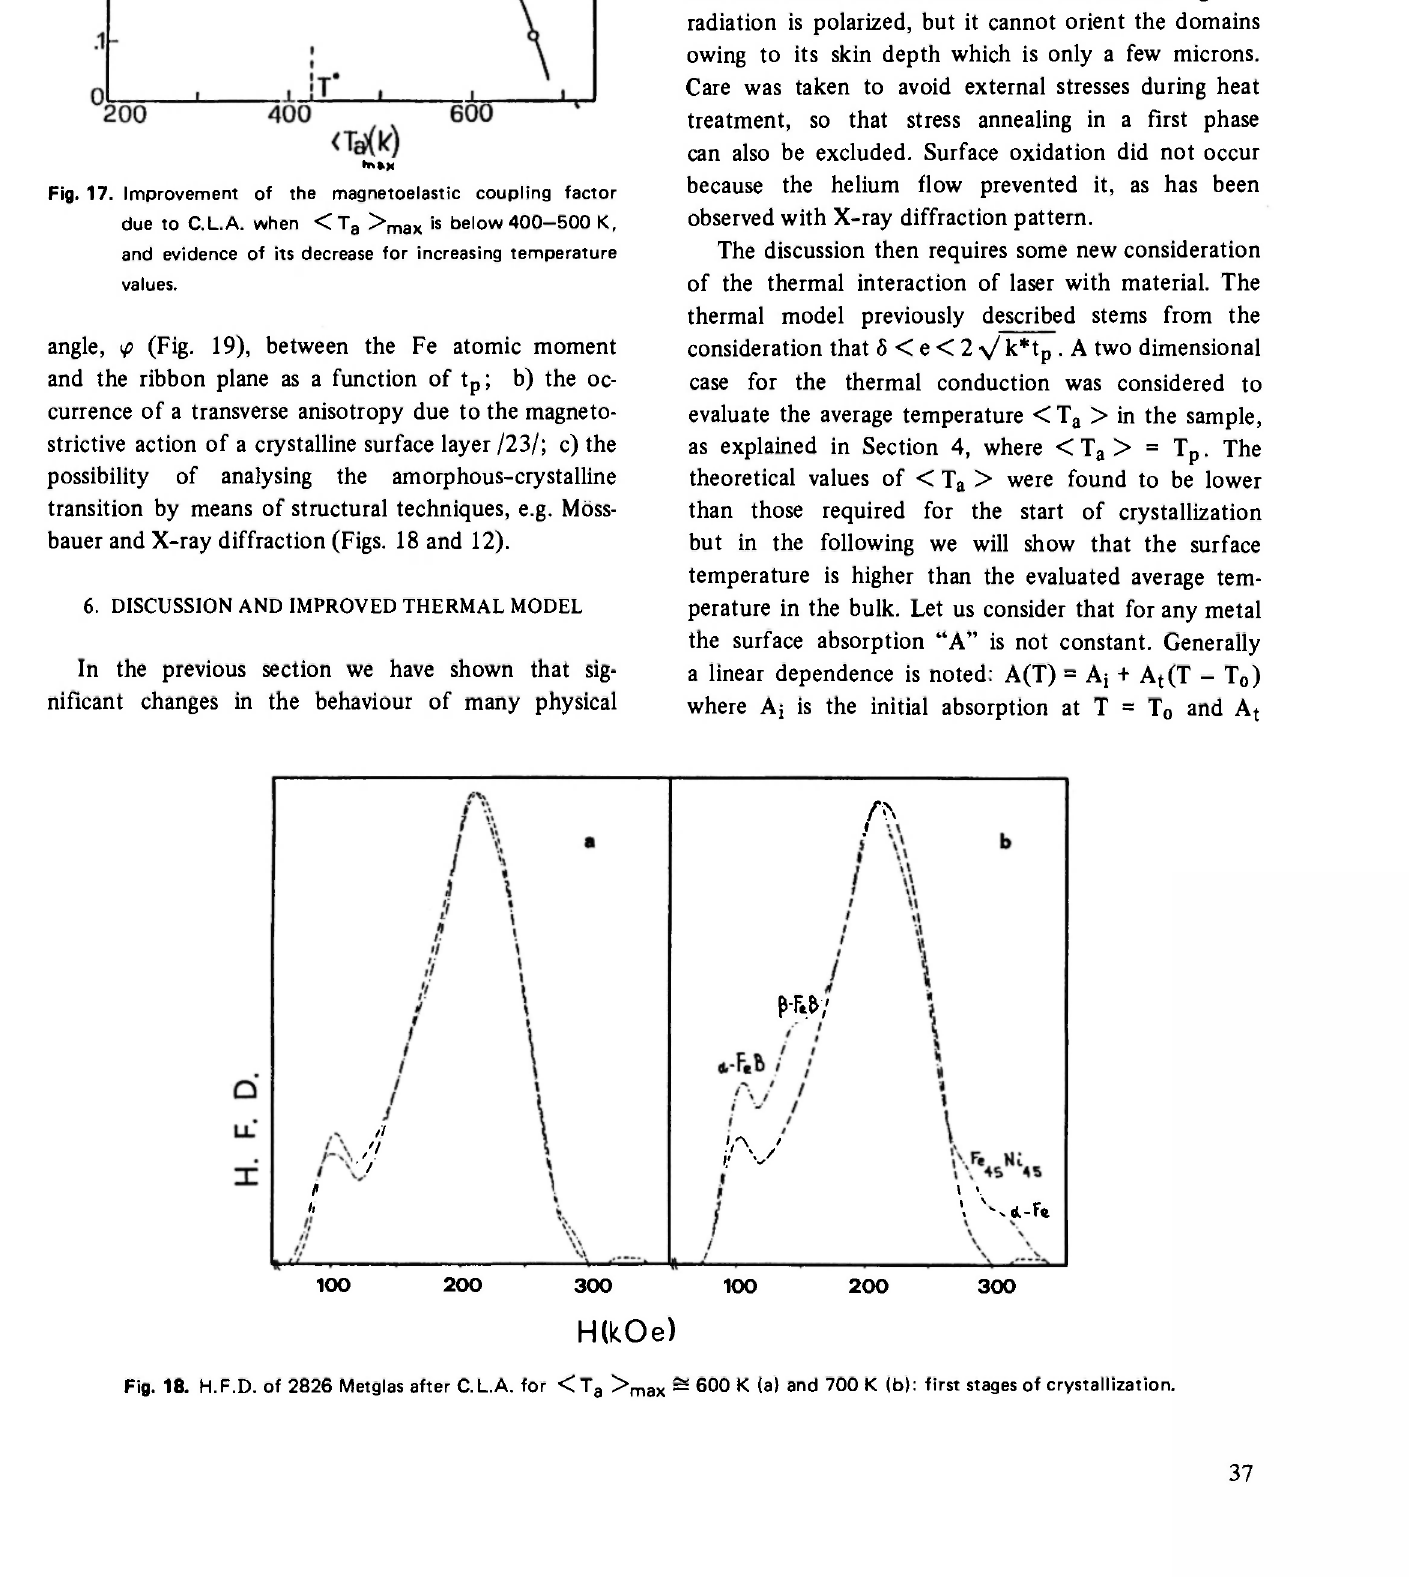
Fig. 18. H.F.D. of 2826 Metglas after C.L.A. for < T a > m ax £ 600 Κ (a) and 700 Κ (b): first stages of